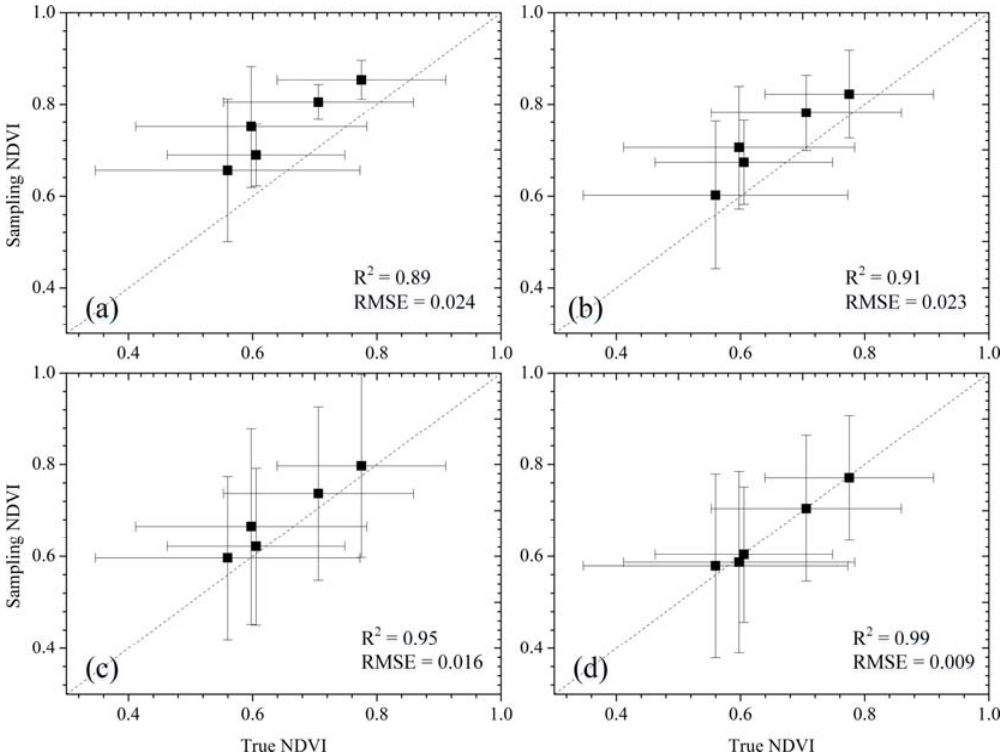
Figure 5. Scatterplots between the average sampled NDVI and the average true NDVI values for the